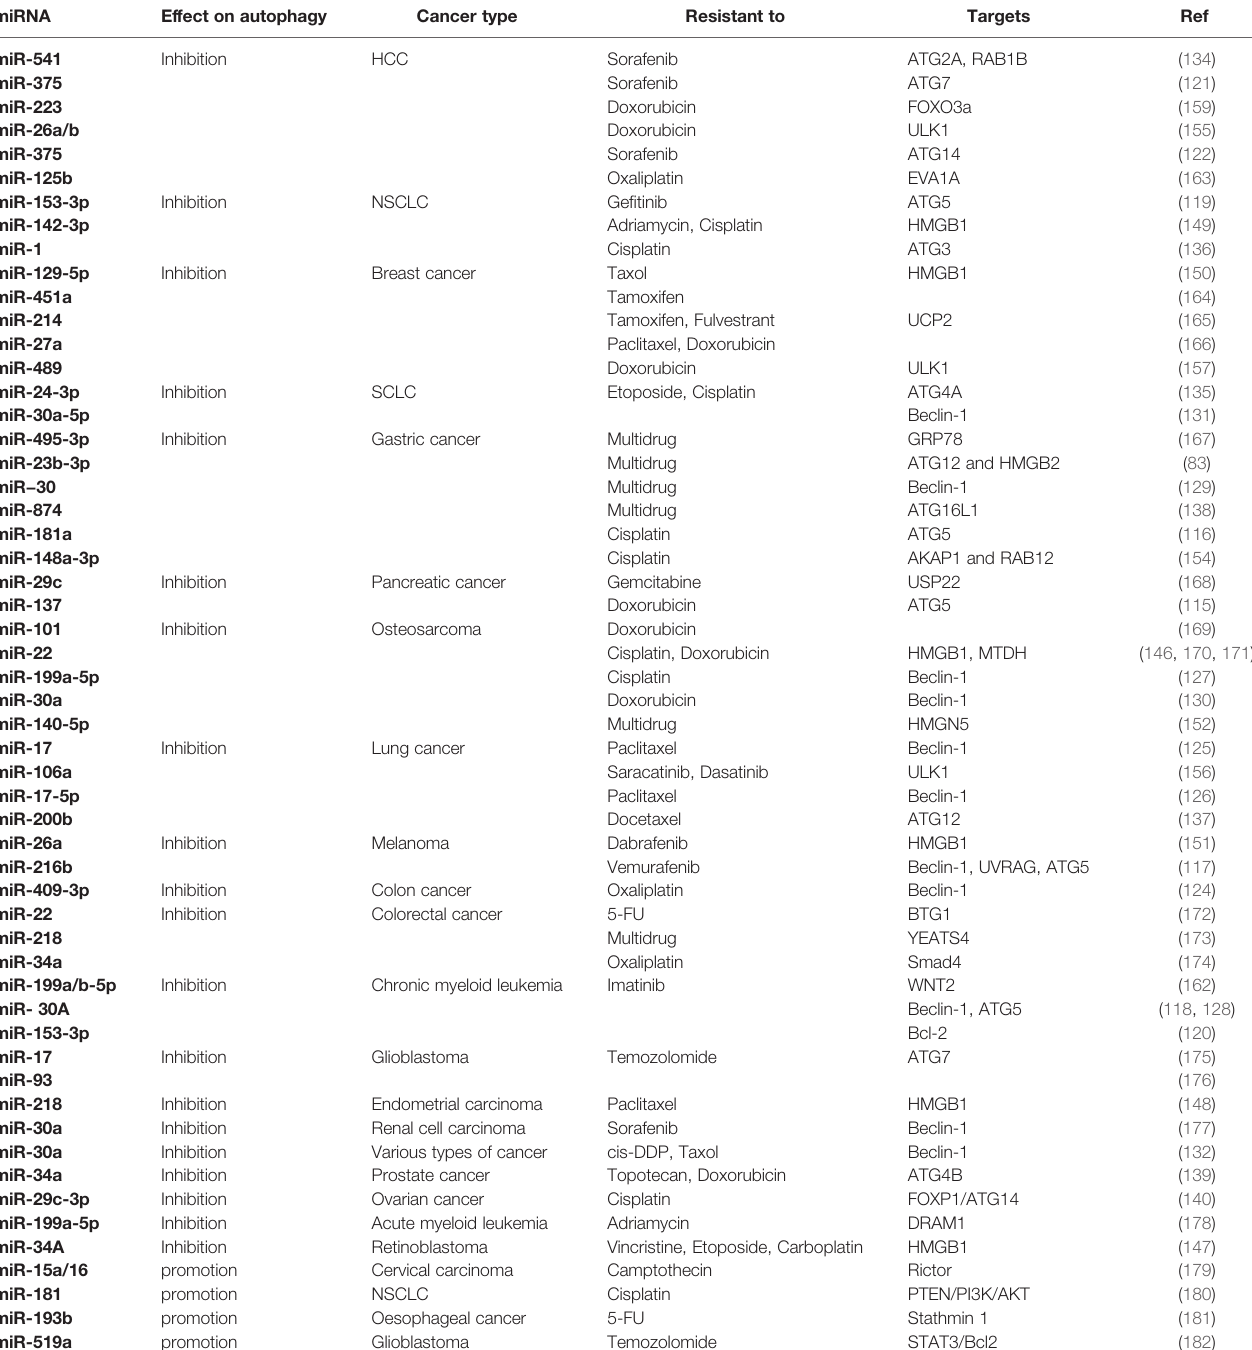
TABLE 1 | Overexpression of miRNA combat chemoresistance by regulating autophagy.